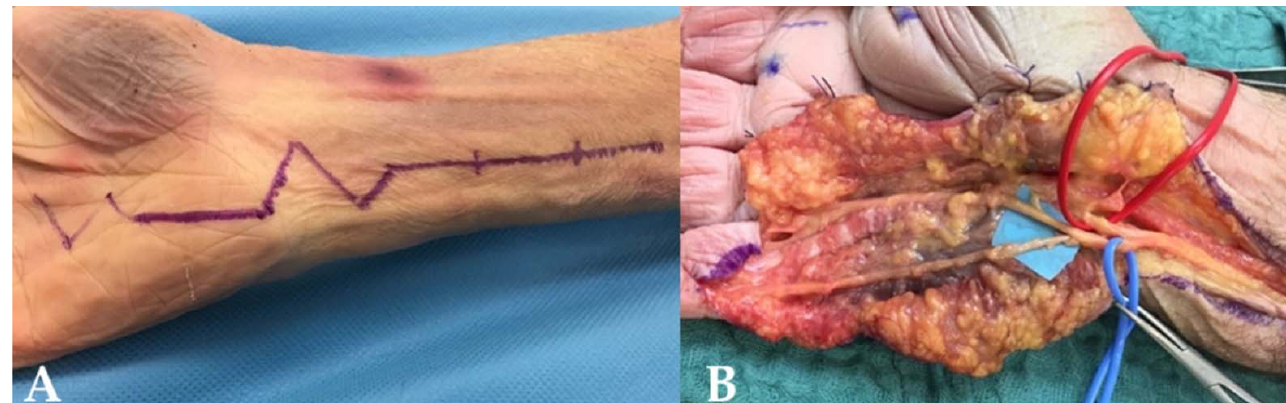
Figure 3. ( A ) The Taleisnik approach: along the axis of the ring finger, the incision reached the radial border of the flexor carpi ulnaris tendon, followed a zigzag pattern at the distal wrist crease. ( B ) Opening of the Guyon canal: The ulnar nerve was dissected, the SBUN was isolated in the blue loop, and the motor branch was separated (red loop). The incision exposed the terminal branches of the SBUN for the fourth and fifth digit.